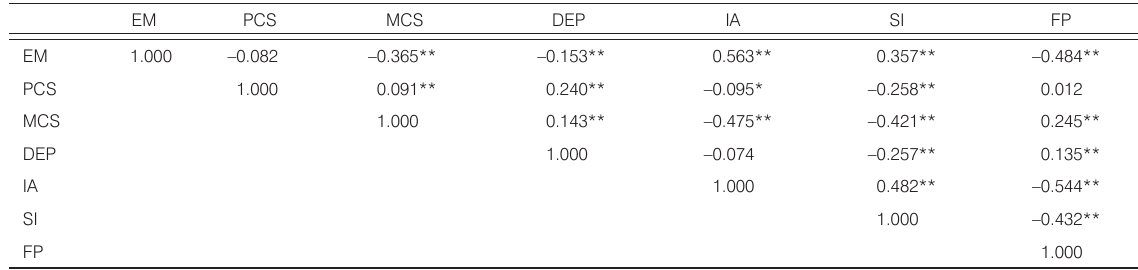
Table 3. Pearson product moment correlation coefficients among variables (N = 489).